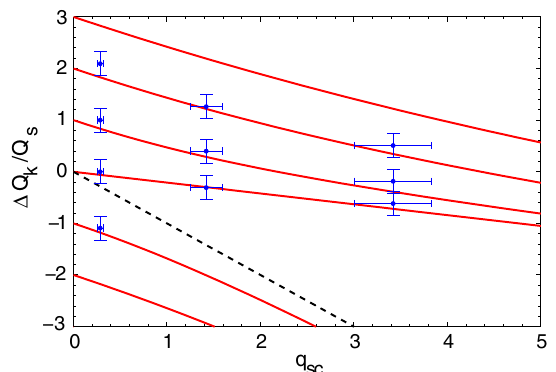
FIG. 13. This plot shows the predicted shifts from analytical Eq. (8) and measured head-tail mode frequencies are overlaid in the vertical plane for U 73 þ ion beam at various current levels (Table I).